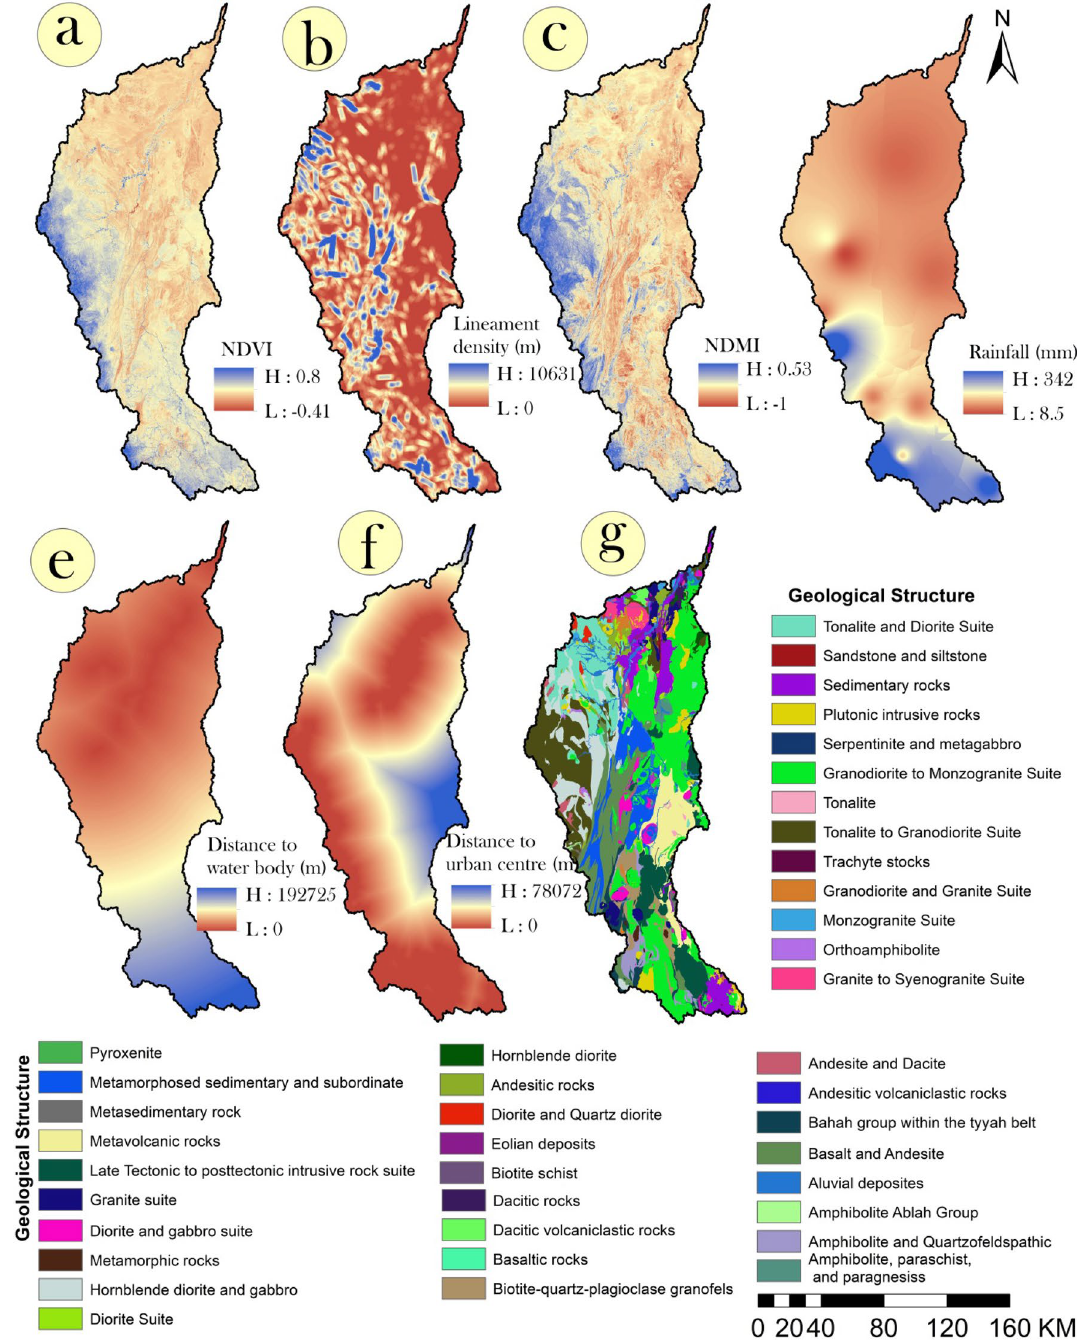
Fig. 4 The conditional parameters for GPM, such as a NDVI, b lineament density, c NDMI, d Rainfall, e distance to waterbody, f distance to urban, g geological